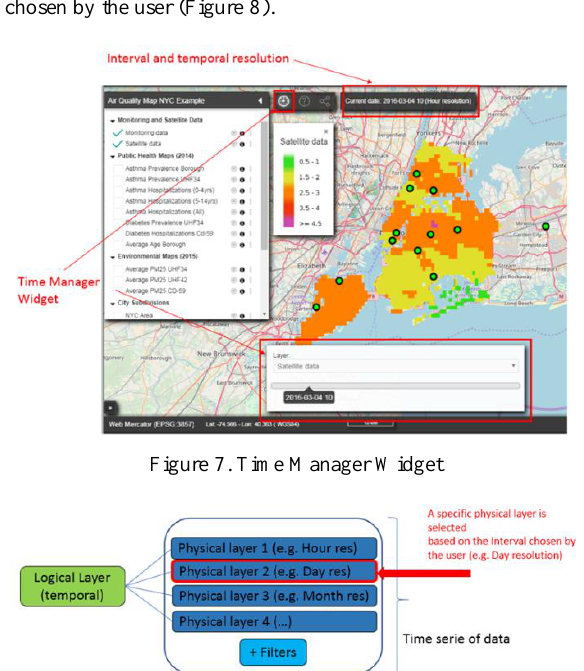
Figure 8. Temporal layers modelled as logical and physical layers association